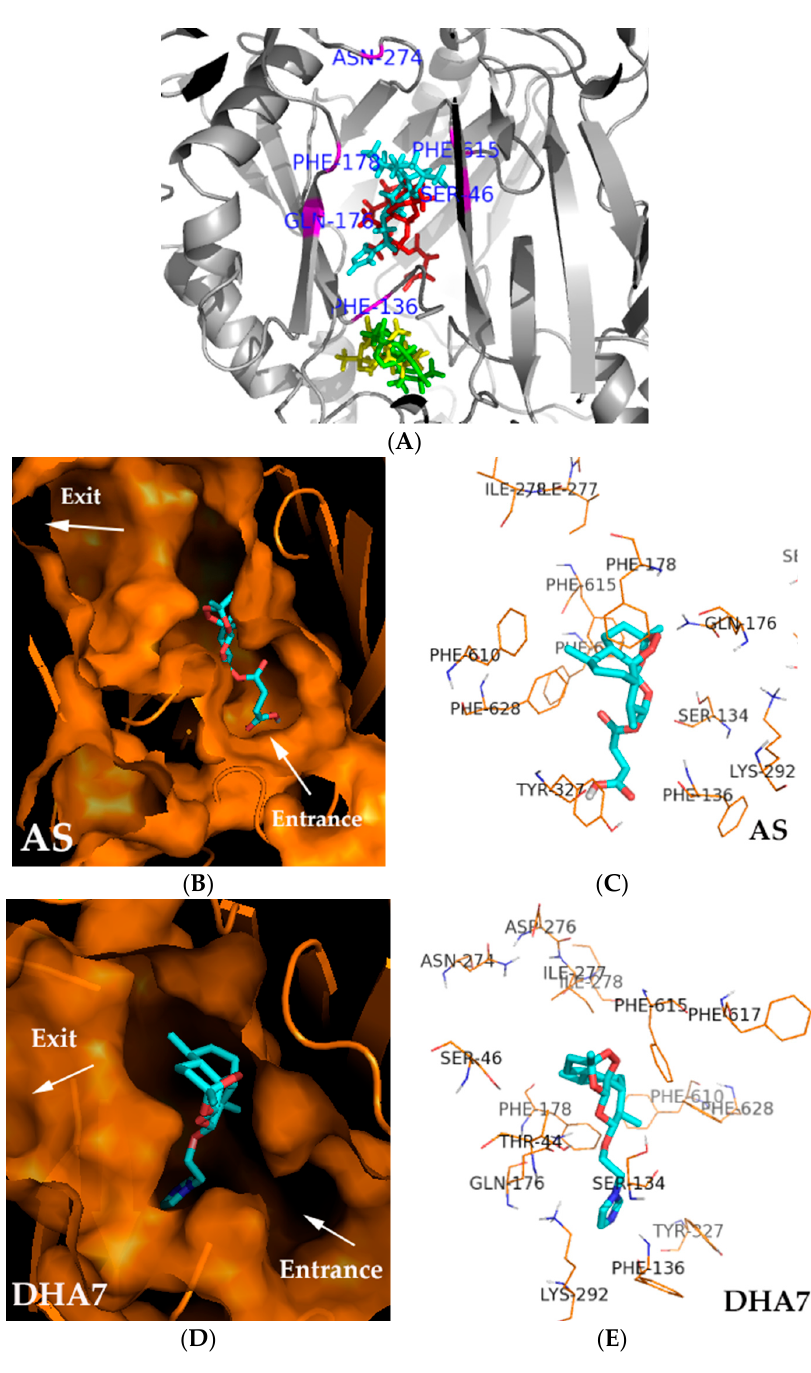
Figure 2. Molecule docking of ART, DHA, AS, and DHA7 to AcrB. Surflex-Dock that adopted an empirical scoring function was employed for molecular docking. The crystal structure of AcrB (PDB ID, 2DRD) was obtained from Protein Data Bank. The molecular docking results were analyzed and represented in the PyMOL 1.3 visualization software. Proteins are shown in gray and orange. The compounds are shown as thick sticks colored according to the compound structure (Figure 2A: red, AS; cyan, DHA7; green, ART; yellow, DHA) and the atom type (Figure 2B–E: red, oxygen; cyan, carbon; dark blue, nitrogen), and residues are shown in brown and marked. ( A ) ART and three ART derivatives including DHA, AS, and DHA7 bind to AcrB; ( B ) Longitudinal section of substrate translocation pathway when AS was docked with AcrB; ( C ) Cartoon view of AS docked with AcrB; ( D ) Longitudinal section of substrate translocation pathway when DHA7 was docked with AcrB; ( E ) Cartoon view of DHA7 docked with AcrB.